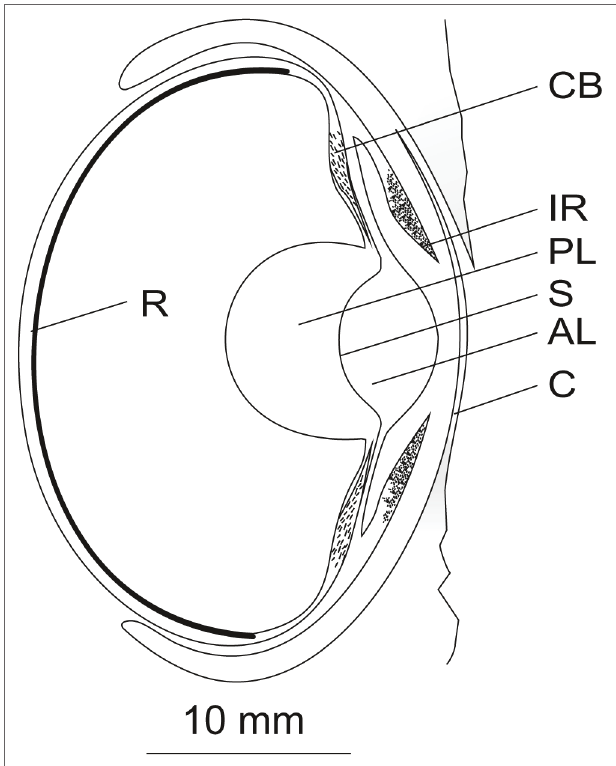
FIGURE 2 | Schematic of the eye of Octopus vulgaris (longitudinal vertical section). Light falling on the eye of octopus first hits the cornea (C). Beyond the cornea, the light passes the anterior chamber and the pigmented mobile iris (IR) before it is refracted by the spherical lens. The lens, composed of an anterior (AL) and a posterior part (PL) separated by a septum (S), is suspended by the ciliary body (CB). Finally, the light hits the everted retina (R) in the back of the eye. A detailed description of the ocular structures is given in the text. The figure was adapted from frozen sections of an octopus eye and from Figure 1 in Budelmann (1994) and Figure 5 in (Wells, 1966b) displaying an eye of Octopus spec. Scale 10